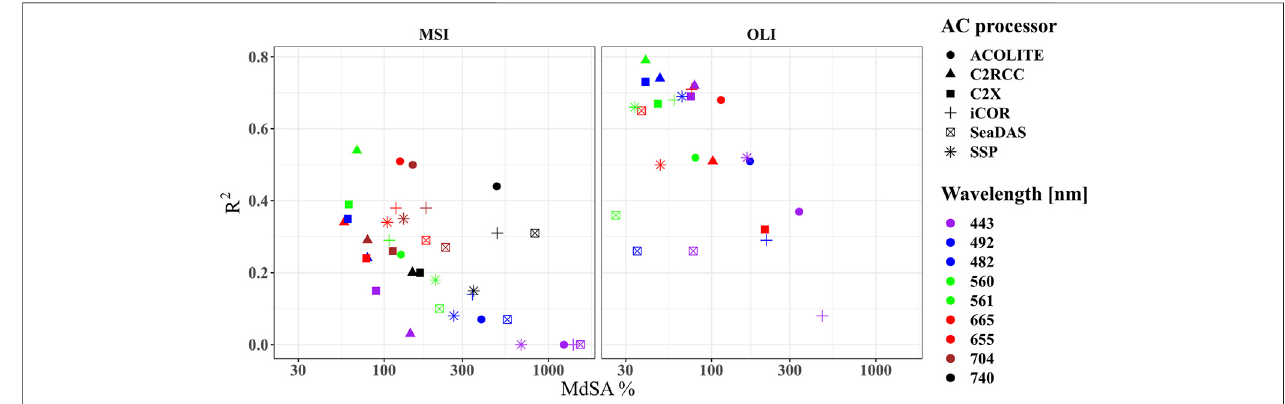
FIGURE 9 | Performance metrics, y-axis coef fi cient of determination, and x-axis median symmetric accuracy, of atmospheric correction processors.